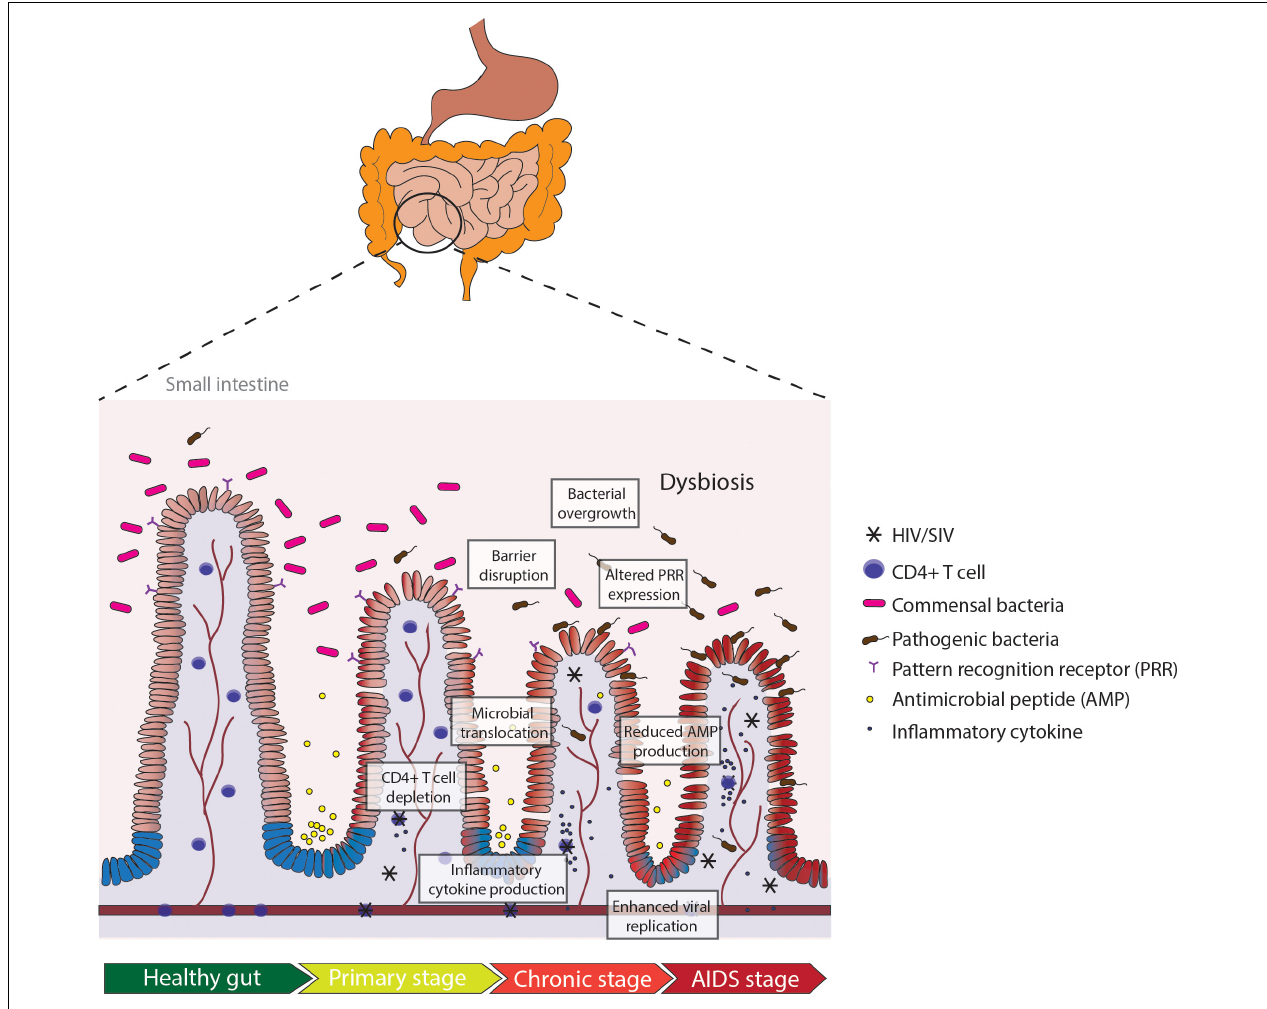
FIGURE 1 | Pathologic manifestations of the small intestine in HIV or SIV infection in the gut. Depletion of CD4 + T cells occurs in early HIV infection (primary stage). Production of inflammatory cytokines in the primary stage leads to intestinal barrier disruption and microbial translocation, exacerbating the inflammatory milieu and increasing viral replication. Dysregulation in mucosal immunity and reduced anti-microbial peptide (AMP) production leads to bacterial overgrowth and altered pattern recognition receptor (PRR) expression in chronic HIV infection. Persistent gut inflammation in response to the cascade of mucosal events leads to enhanced viral replication and severe depletion of CD4 + T cells in the AIDS